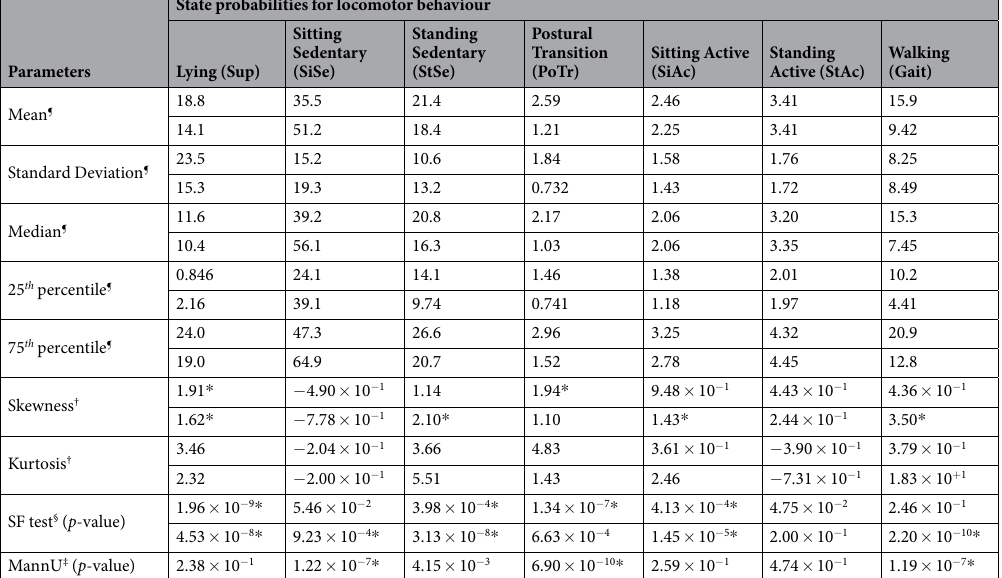
Table 1. Summary statistics of the probability of physical activity for the control and dementia groups. The first four moments (mean, standard deviation, skewness, and kurtosis), the three quartiles (first, median and third), and tests for normality (Shapiro-Francia), and the Mann-Whitney U test for similarity of distribution are shown. The cells with asterisks show significant behaviour at the p < 0.001. Refer to the table notes and the text for further discussion. The top and bottom rows for each parameter represent the statistics for control and dementia subjects respectively. ¶ These rows shows the value of the state probabilities ( π j × 100) for clearer interpretation. † The significant skewness and kurtosis are marked with asterisks, following the discussion in Cramer 43 . § The p –values for the Shapiro-Francia test are shown. The p –values marked with asterisks show significant difference between the two groups at 99.9% confidence level ( p < 0.001). ‡ The p –values for the Mann- Whitney U test are shown. The p –values marked with asterisks ( * ) show significant difference between the two groups at 99.9% confidence level ( p <